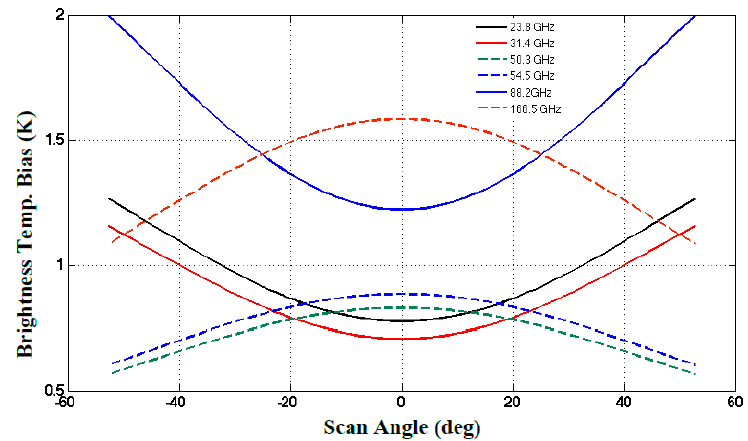
Figure 5. Brightness temperature biases simulated at cold space view where the microwave radiation is uniform across the scan angle. Reflector temperature is assumed as 283 K and its emissivity varies from 0.0028 to 0.0043 within 23 to 167 GHz.